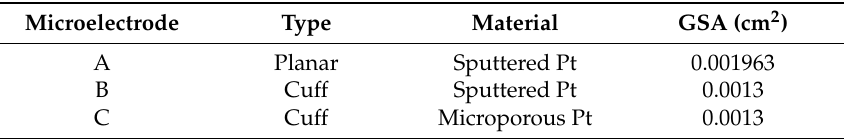
Table 1. Pt microelectrodes characterized in present